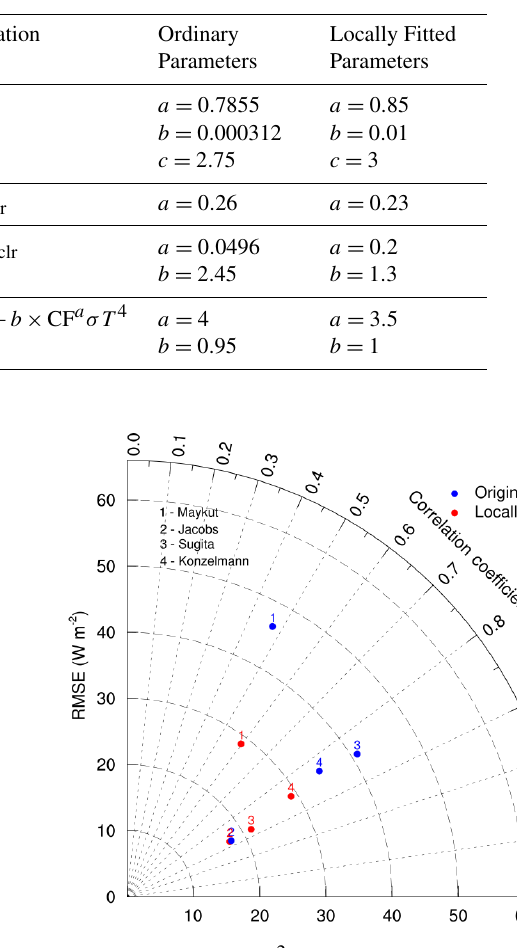
Figure 4. RMSE and R 2 for the cloudy-sky DLR (DLR cld ) parametrizations using the original (blue) and locally calibrated (red)